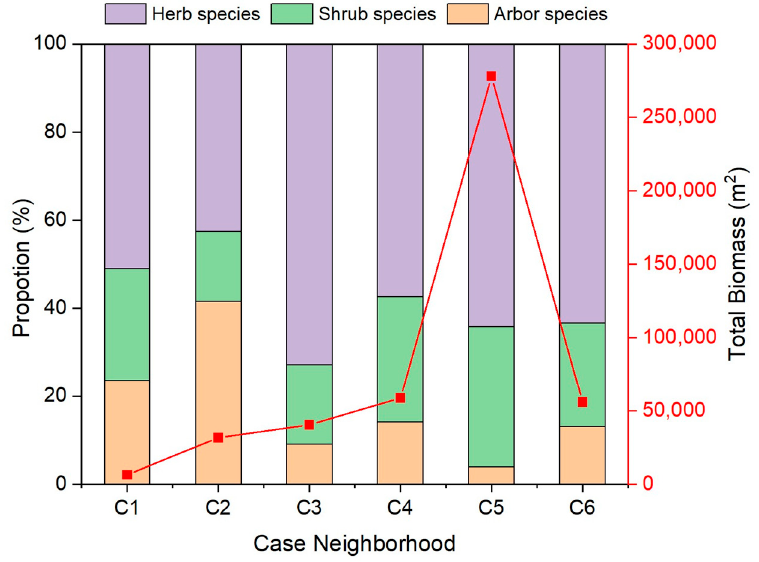
Figure 5. Structure of green quantity of the six case neighborhoods.